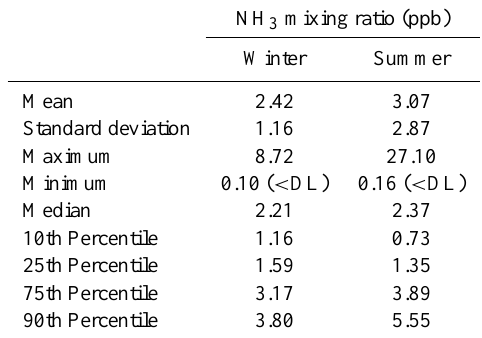
Table 2. Statistics of NH 3 data collected during the two sampling periods ( < DL indicates numbers below the detection